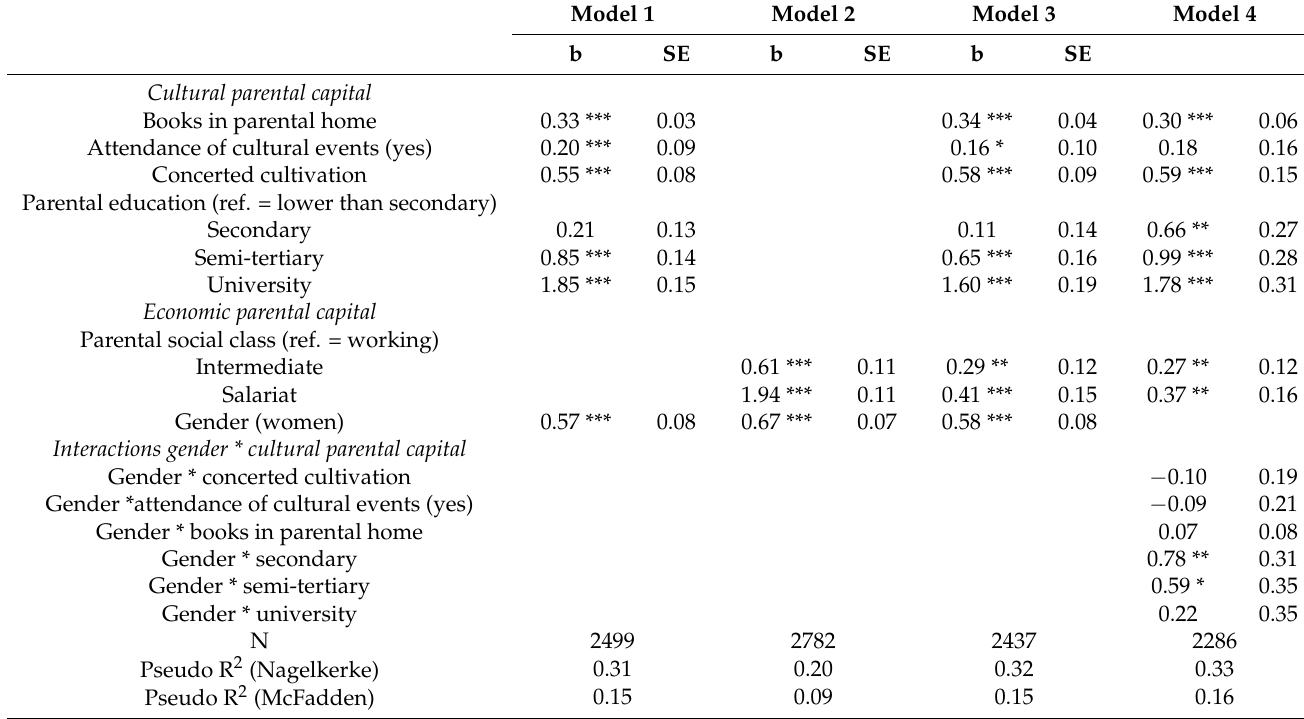
Table 4. Respondents’ educational attainment conditional to parental cultural and economic